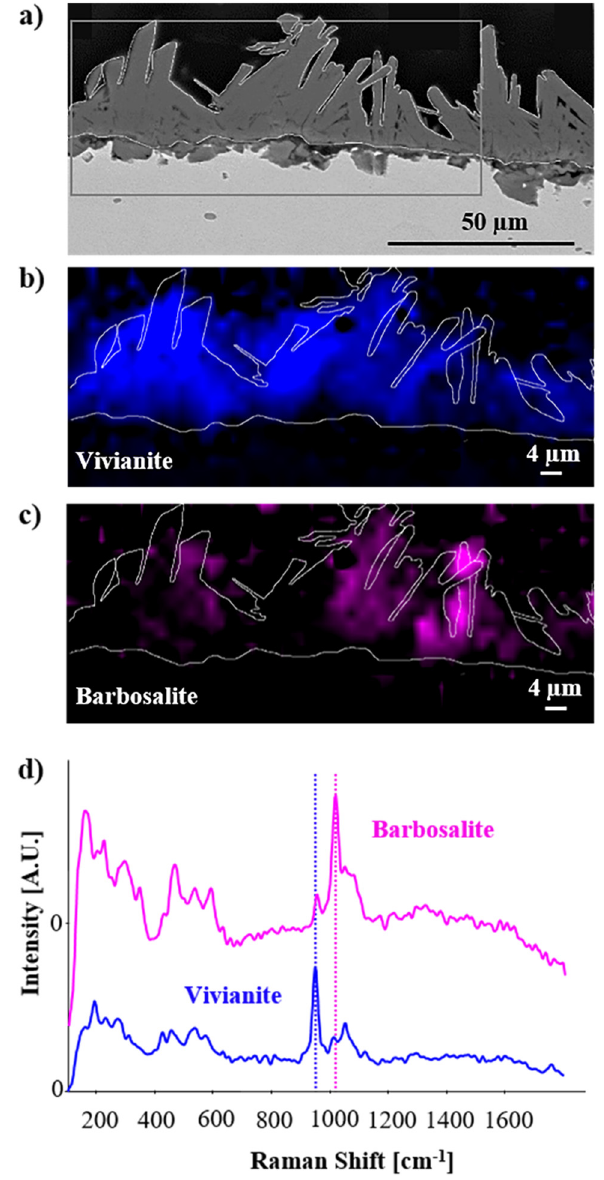
Figure 7. Molecular mapping performed by Raman spectroscopy on bacterially treated iron coupons: ( a ) image of secondary electrons with a square box indicating the area analyzed by Raman spectoscopy, chemical maps ( b ) of vivianite (Vi, blue) and ( c ) of barbosalite (Ba, pink), and ( d ) Raman spectra of vivianite and barbosalite with the corresponding spectral regions selected for the elaboration of the respective chemical maps of vivianite (indicated with blue dashed lines) and barbosalite (indicated with magenta dashed lines).